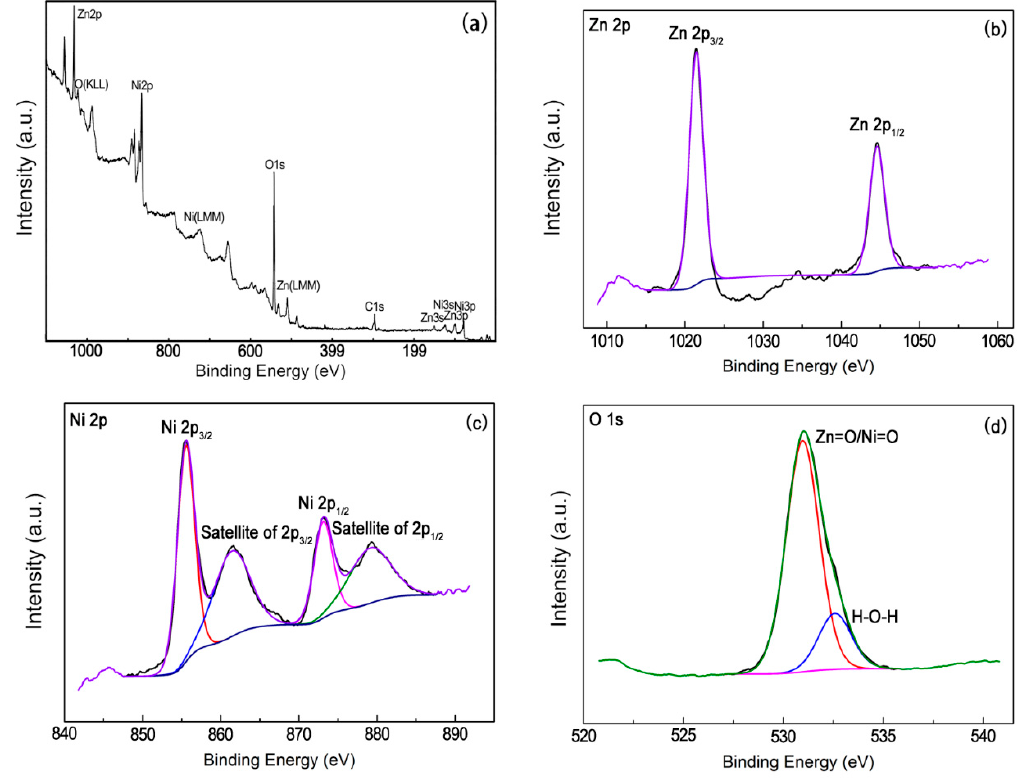
Figure 4. XPS spectra of ( a ) full spectrum, ( b ) Zn 2p, ( c ) Ni 2p, and ( d ) O 1s.